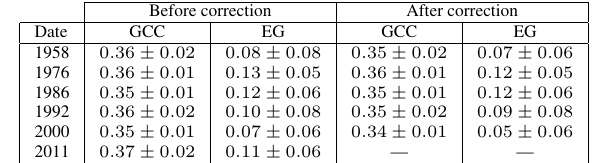
Table 3. Mean and standard deviation for GCC and EG, before and after correction, for each of the studied